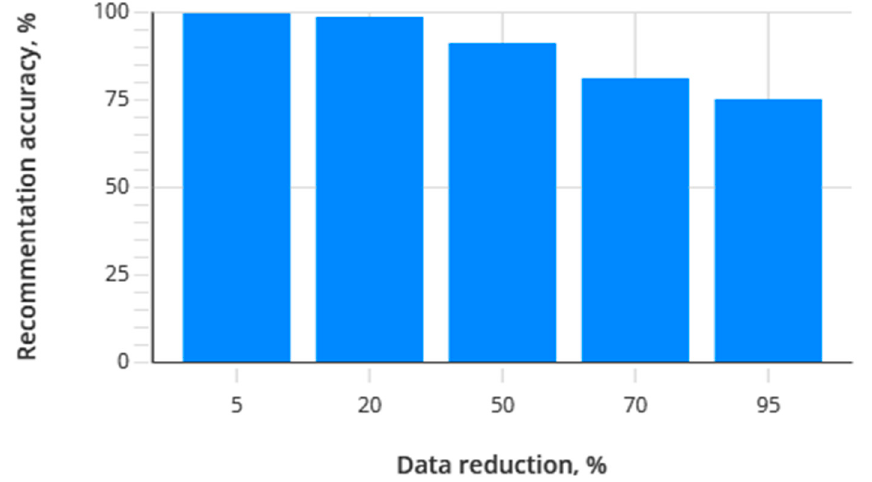
Figure 7. Recommendation accuracy dependence on data reduction.